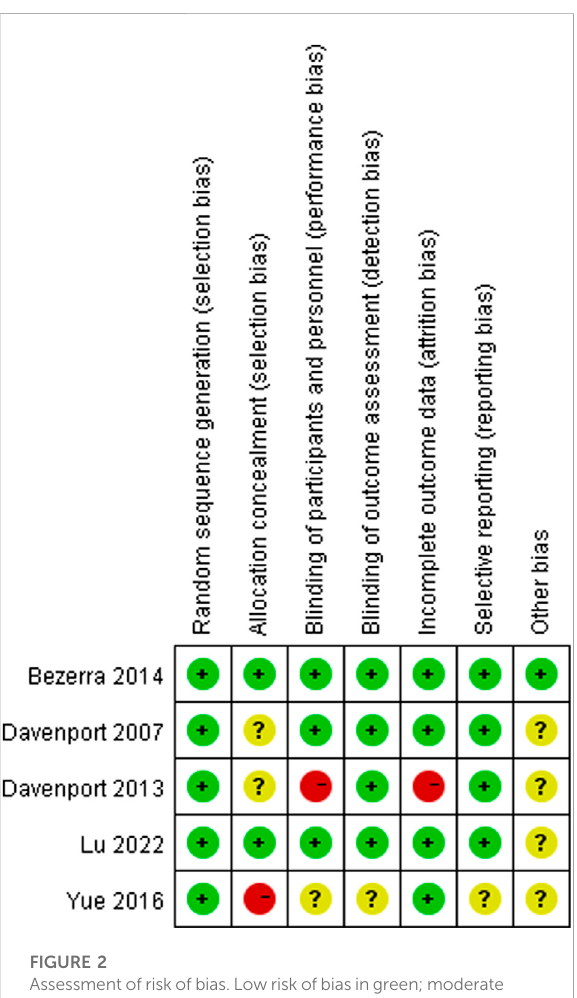
FIGURE 2 Assessmentofriskofbias.Lowriskofbiasingreen;moderate risk of bias in yellow; high risk of bias in